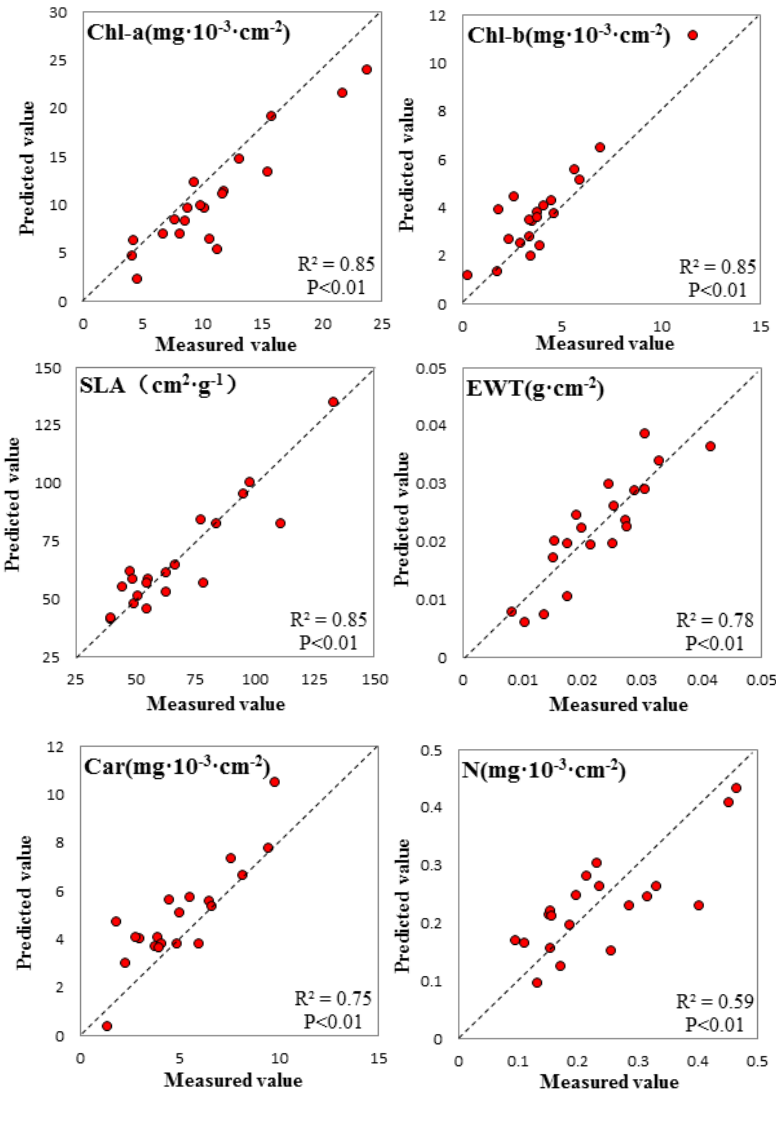
Figure 4. Hierarchical cluster analysis of 20 dominant species based on their spectral reflectance signatures from 400 to 2400